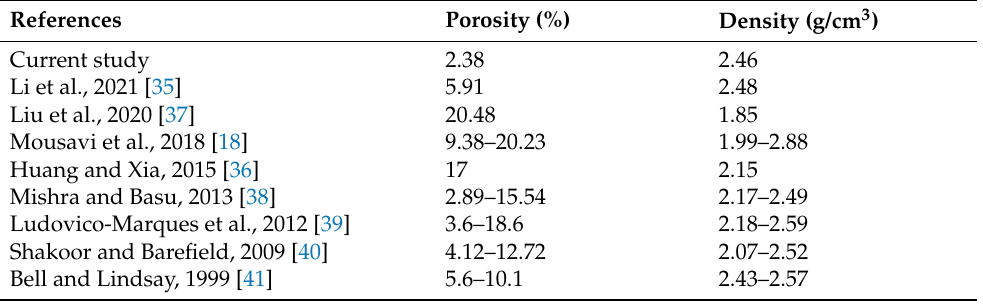
Table 2. Porosity and density of sandstone.